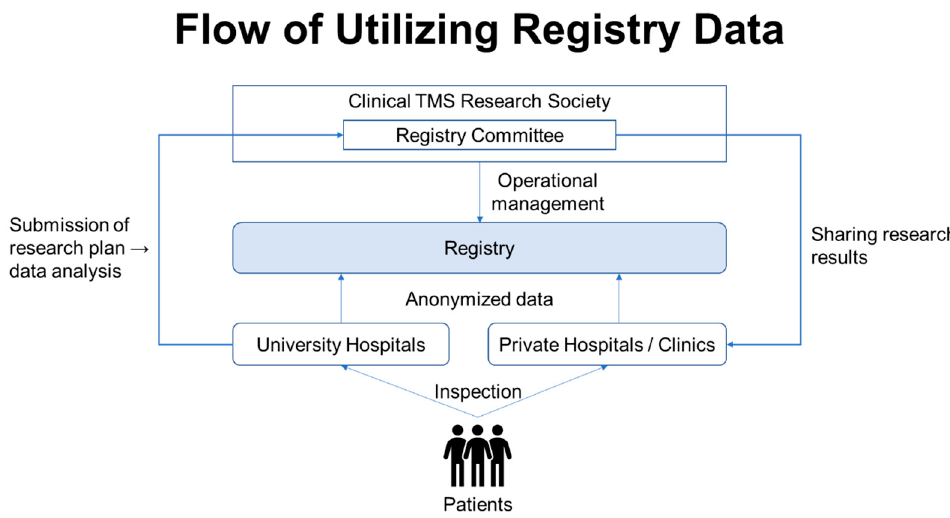
Figure 5. Flowchart diagram of the application and approval process for using the TMS registry data. The use of TMS registry data is limited to the members of the Japan Society for Clinical TMS Research, who must first submit a proposal to the society regarding the purpose of use and analysis. The registry data will be made available to the researchers upon approval of the proposal by the registry data use review committee established within the Japanese Society for Clinical TMS Re- search.